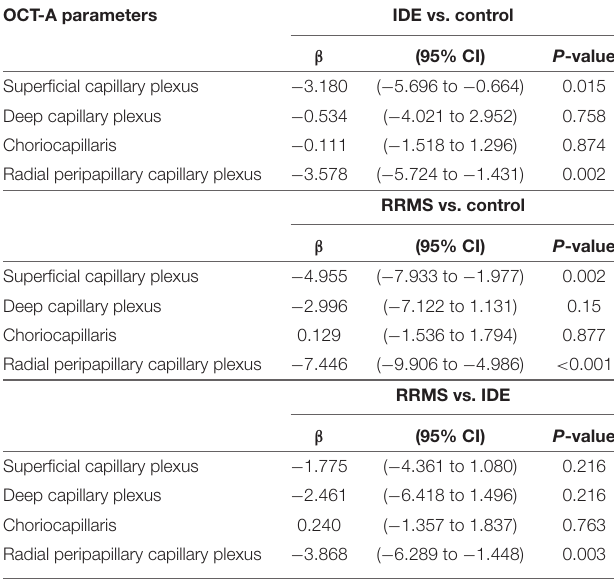
TABLE 2 | Differences in OCTA parameters among IDE, RRMS and control groups. OCT-A